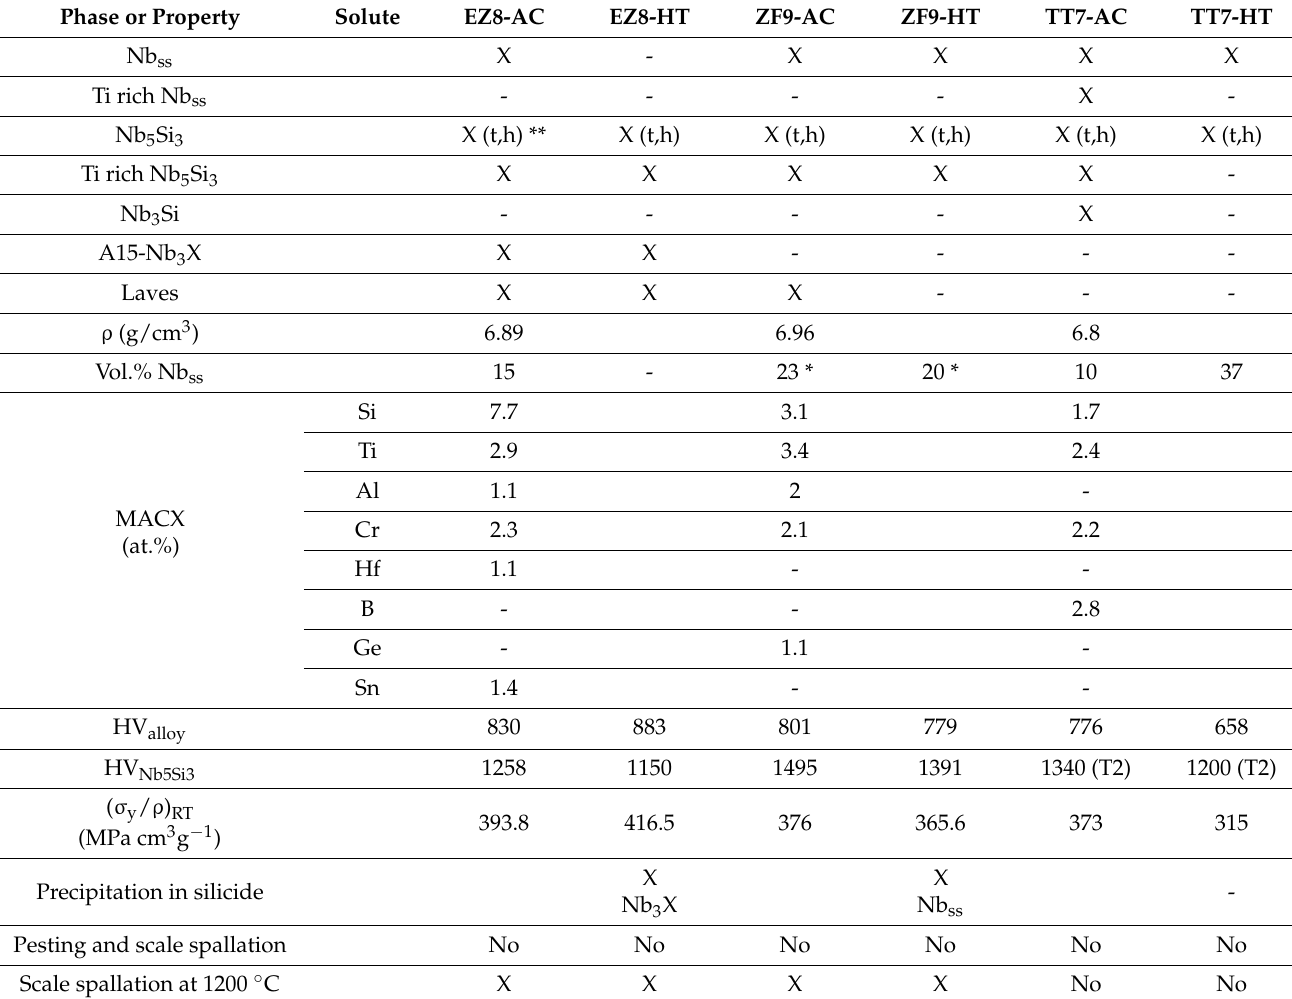
Table 10. Comparison of the RM(Nb)ICs/RCCAs EZ8, ZF9 (38Nb-24Ti-18Si-5Al-5Ge-5Hf-5Cr